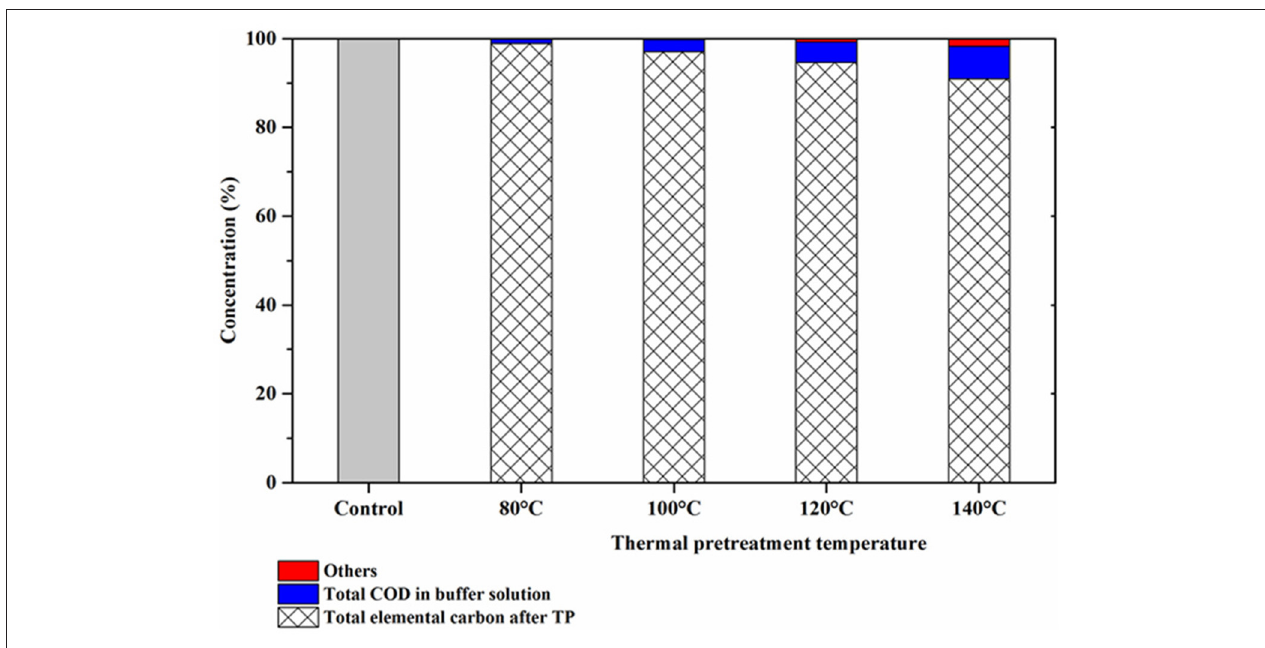
FIGURE 6 | Carbon balance of FW for each TP investigated.